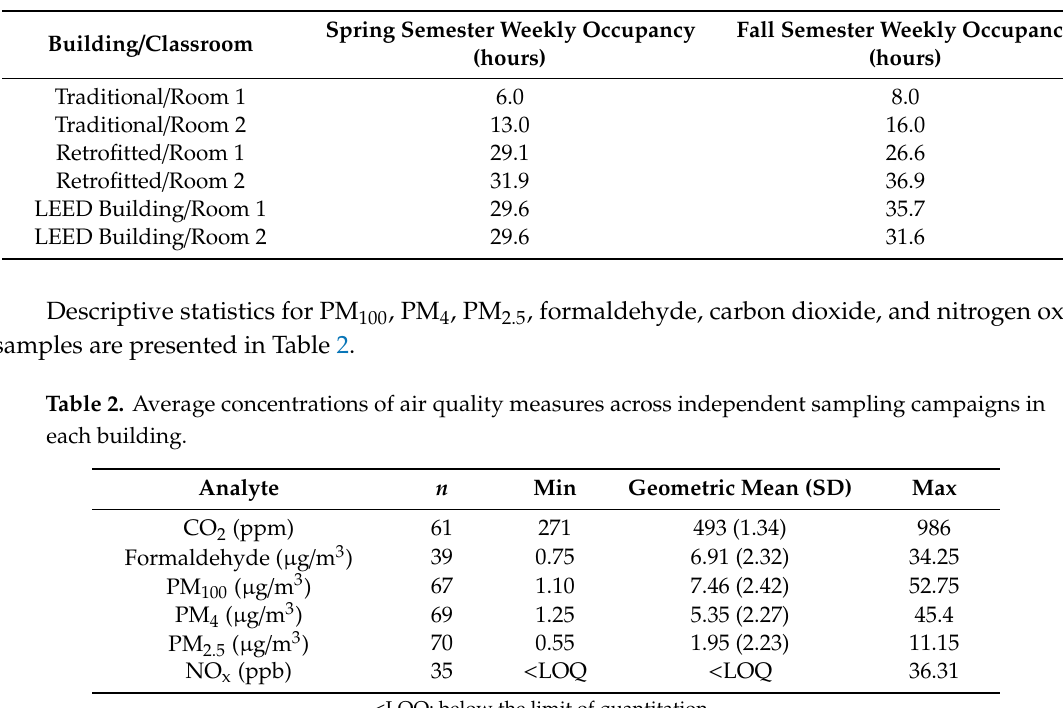
Table 1. Average time occupied per week by classroom and semester.